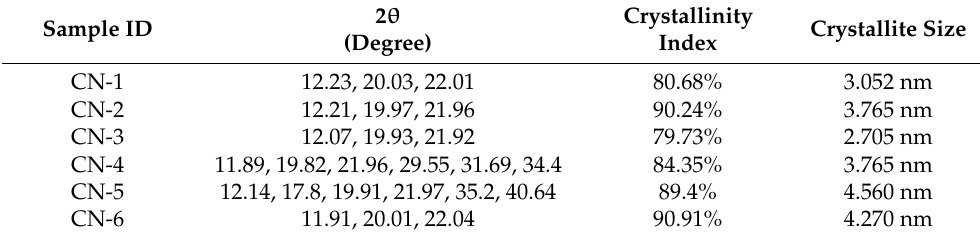
Table 2. Crystallinity index and crystallite size of different CNC samples.